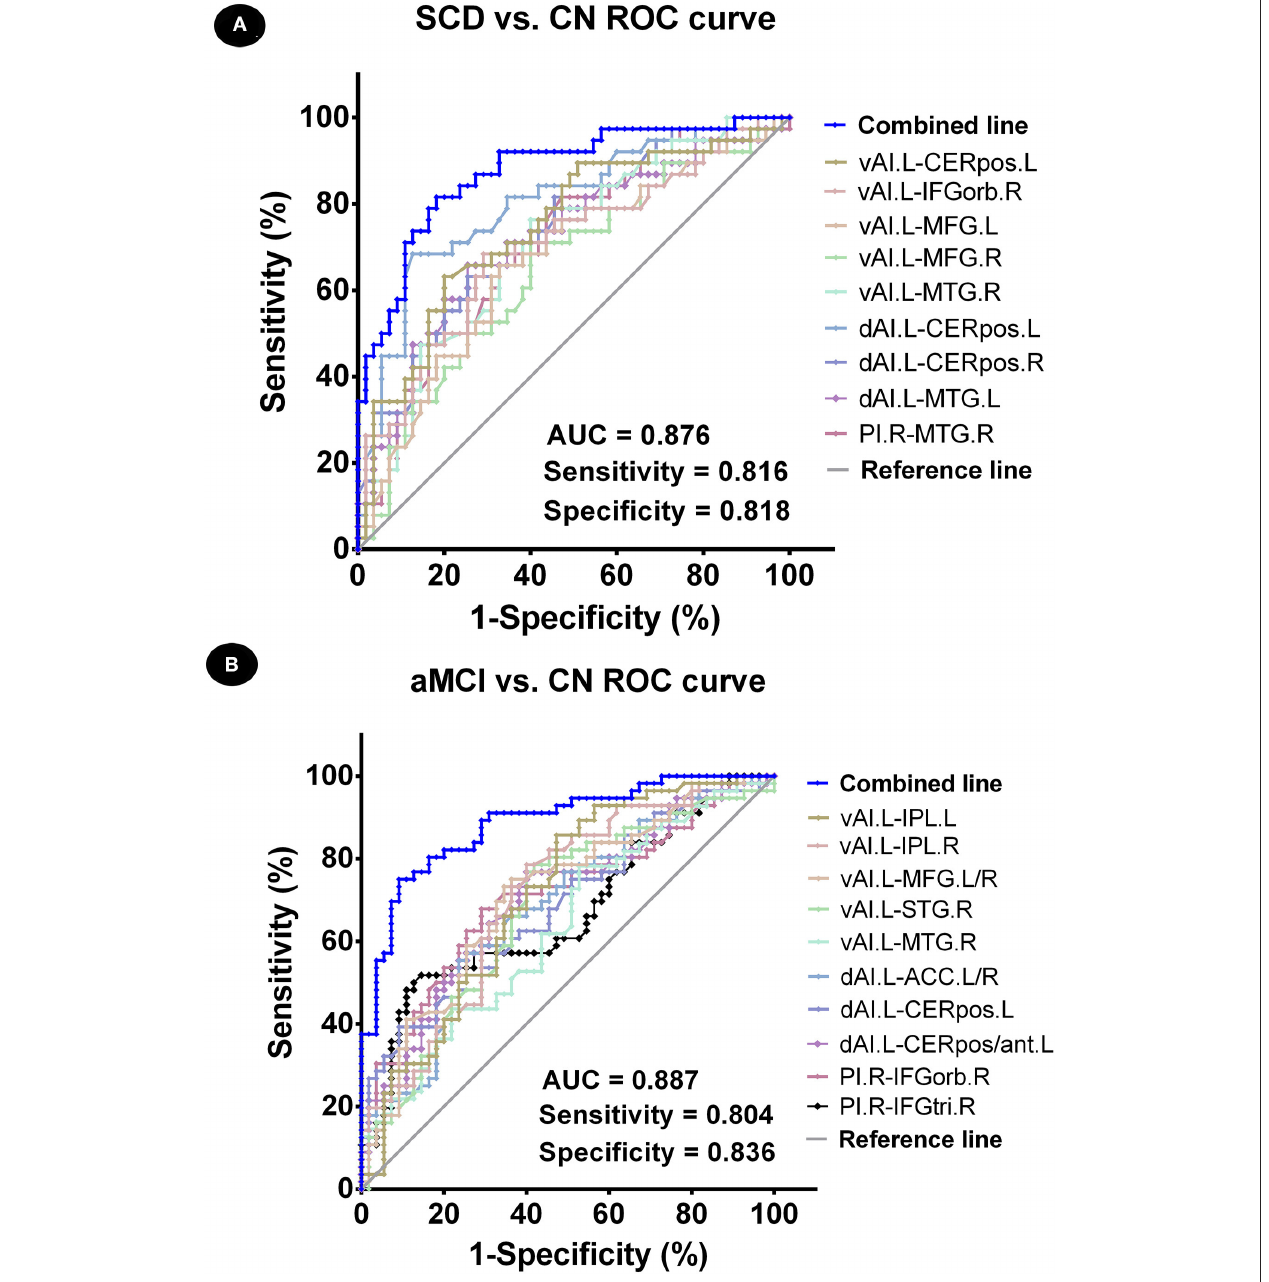
FIGURE 3 | Classification of individuals as SCD vs. CN and aMCI vs. CN using an MRI-based classifier. (A) ROC curve showcasing the classification power using an MRI-based “classifier” of SCD from CN. (B) ROC curve presetting the classification power using MRI-based “classifier” of aMCI from CN. Note: the values of AUC, sensitivity, and specificity are displayed in the lower right region of the figure. The combined line reflects the combination of indices of abnormal insular subnetwork functional connectivity. CN, normal control; SCD, subjective cognitive decline; aMCI, amnestic mild cognitive impairment; AUC, area under the ROC curve; ROC, receiver operating characteristic; vAI.L, left ventral anterior insula; dAI.L, left dorsal anterior insula; PI.R, right posterior insula; CERpos.L, left cerebellum posterior lobe; CERpos.R, right cerebellum posterior lobe; MTG.R, right middle temporal gyrus; IFGorb.R, right inferior frontal gyrus, orbital part; MFG.R, right medial frontal gyrus; MFG.L, left medial frontal gyrus; MTG.L, left middle temporal gyrus; IPL.L, left inferior parietal lobule; IPL.R, right inferior parietal lobule; STG.R, right superior temporal gyrus; ACC.L/R, anterior cingulate cortex; CERpos/ant.L, left cerebellum posterior lobe/cerebellum anterior lobe; IFGtri.R, right inferior frontal gyrus, triangular part.